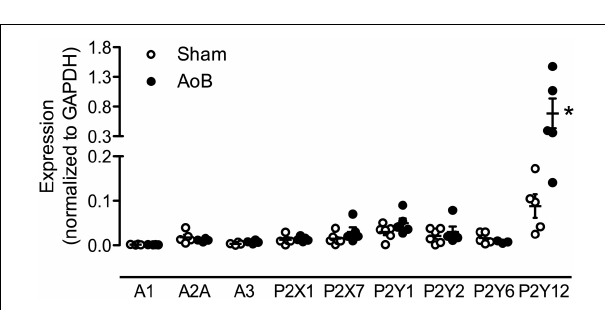
FIGURE 2 | Reduced vasodilator responses to Up 4 A in coronary small arteries from swine with AoB ( n = 6) as compared to Sham-operated ( n = 8) or Slaughterhouse ( n = 5) swine. ∗ P < 0.05 AoB vs. Sham or Slaughterhouse.